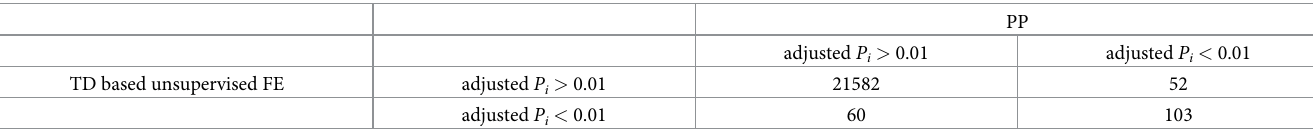
Table 5. Confusion matrix of selected genes between TD-based unsupervised FE and PP in the third data set. P -value computed by Fisher’s exact test is 1.40 × 10 − 241